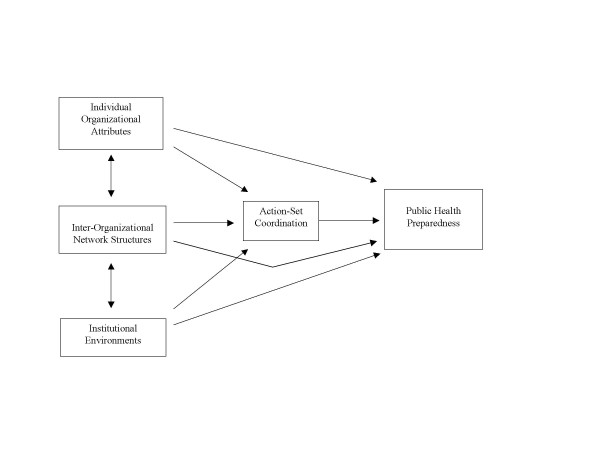
PHP Systems Conceptual Framework.